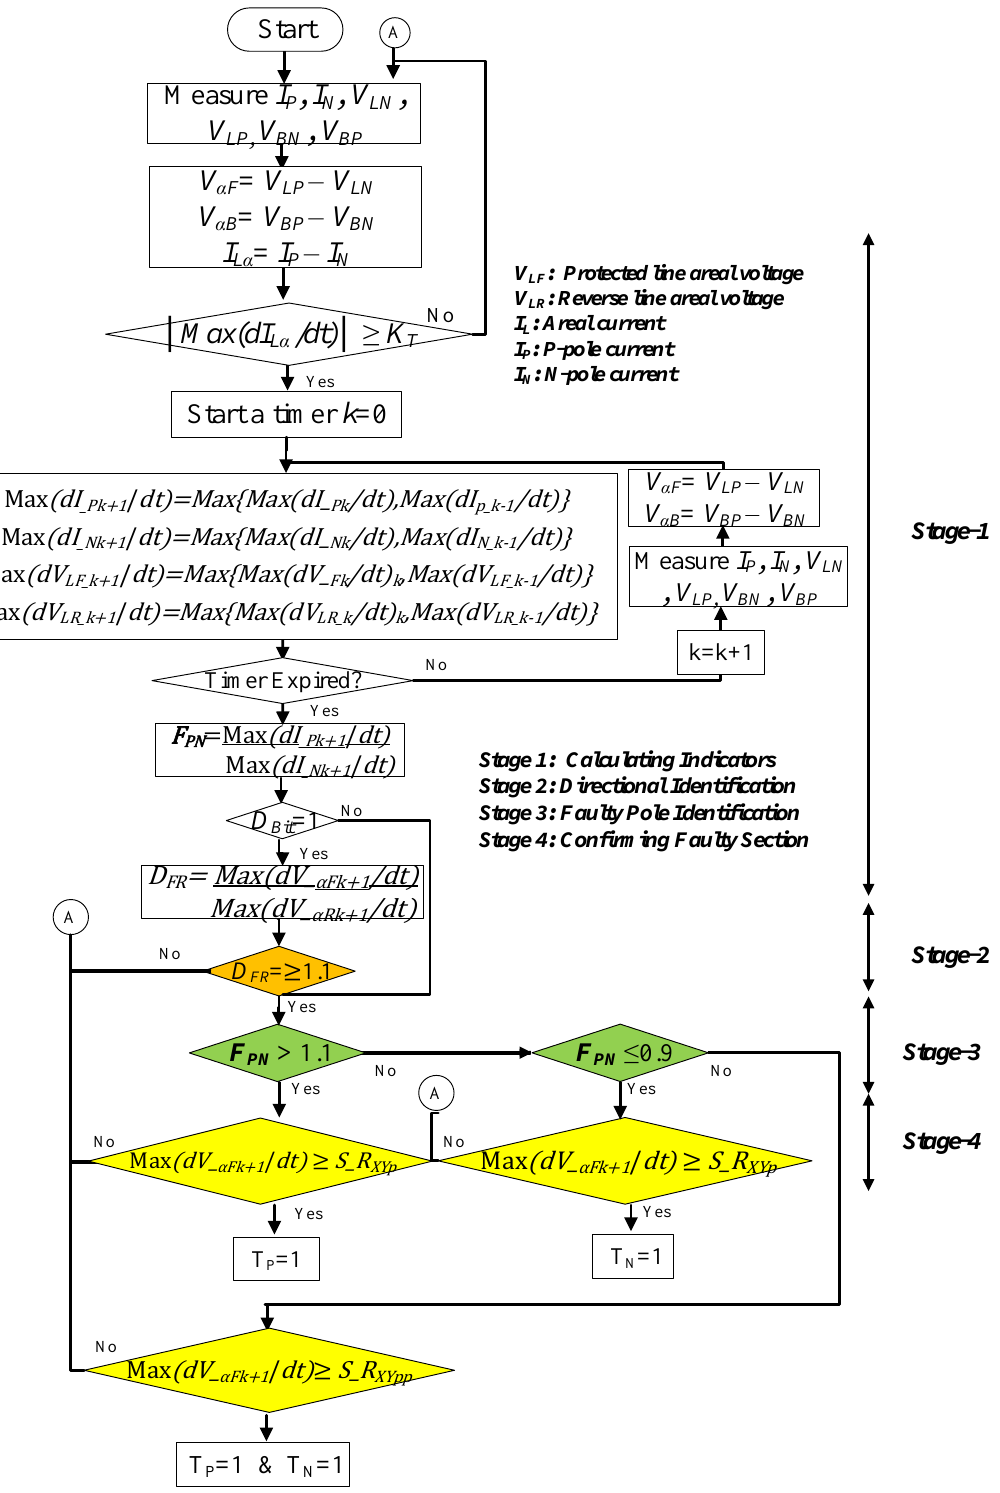
Figure 5. Fault discrimination algorithm.